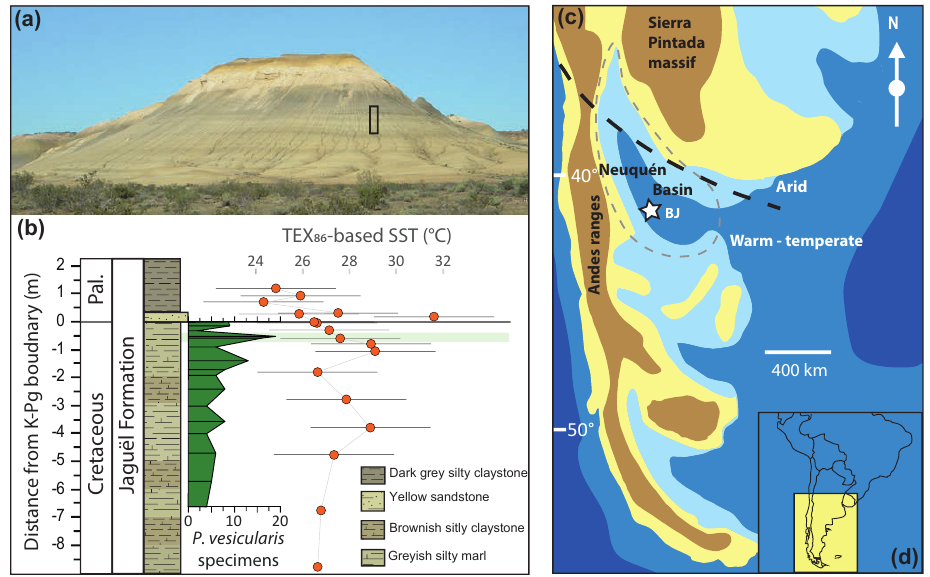
Figure 1. Background information of the studied Pycnodonte vesicularis specimens. (a) The Bajada de Jaguël section in outcrop (BJ; modern location: 38 ◦ 06 (cid:48) 10.5 (cid:48)(cid:48) S, 68 ◦ 23 (cid:48) 20.5 (cid:48)(cid:48) W; palaeolatitude = 43 ◦ S). (b) lithology, stratigraphy and TEX 86 record (Woelders et al., 2017) of the BJ section. The main P. vesicularis level is indicated in light green. The abundance of P. vesicularis is based on Aberhan and Kiessling (2014). (c) Palaeogeography of study area during the latest Cretaceous. Palaeomap after Scasso et al. (2005) and Woelders et al. (2017). (d) Location of the study area in southern Argentina relative to modern-day South